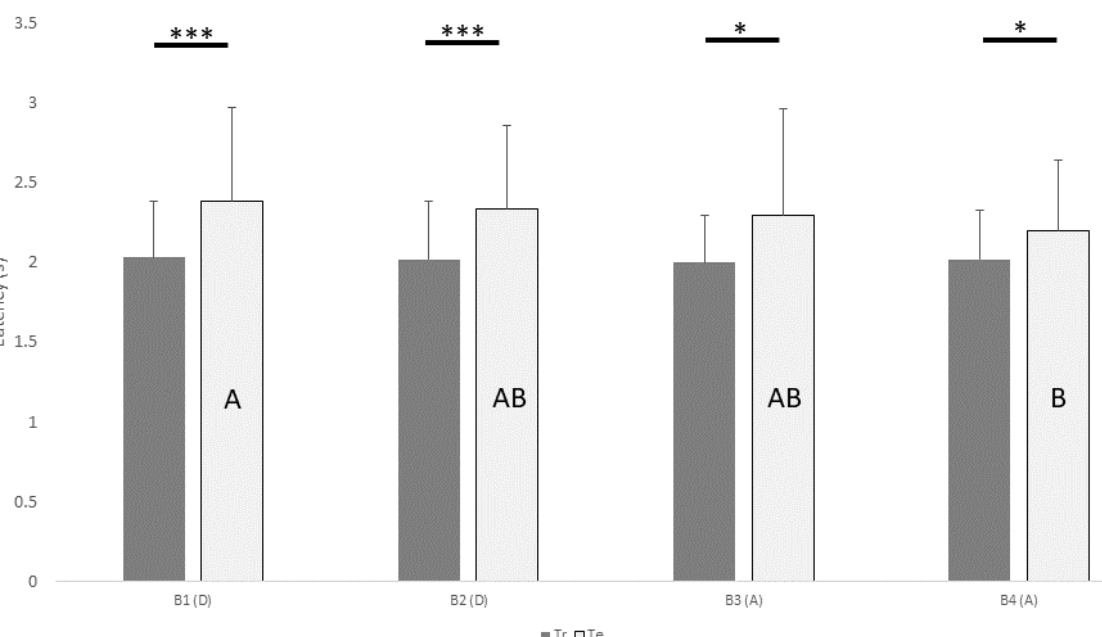
Figure 4. Mean ± SD of the latency from production of sound to the dog’s choice, as function of batch (B1-B4) and type of trial. Significant differences in means between training and test trials within the same batch are flagged by asterisk(s) (* p < 0.05, *** p ≤ 0.001). S ignificant differences in means in test trials between different batches are indicated by different capital letters (e.g. A indicates a signifi- cantly different mean compared to B, but not compared to AB), pairwise comparison after general- ized estimating equations model). Tr, training; Te, testing; D, descending; A, ascending. Post hoc pairwise comparison between latency in training (Tr) and test trials (Te) within each batch showed significant difference in all batches (B1: Tr = 2.0 s, B1: Te = 2.4 s; p = 0.001; B2: Tr = 2.0 s, B2: Te = 2.3 s; p < 0.001; B3: Tr = 2.0 s, B3: Te = 2.3 s; p = 0.040; B4: Tr = 2.0 s, B4: Te = 2.2 s; p = 0.035). Regarding only test trials, the latency time in B1 was higher than in B4 (B1: Te = 2.4 s, B4: Te = 2.2 s; p = 0.002). No difference was found in latency time within the training trials among all batches. No difference was found in latency according of the type of reversal (success/failure). 4. Discussion The MAA of the dogs involved in this experiment ranged from 1.3° to 13.2°, with an average of 7.6°. The dog’s localization ability increased across the experiment, with an average MAA of 11.8° at the beginning of the entire procedure, to 7.4° at the end of it. Dogs’ improvement across the experiment was also evident by a slight decrement in their latency to choose, which went from 2.4 s to 2.2 s. The MAA found in dogs of our experiment had a wider range than that reported for dogs in the scientific literature [15,16], and, in most of our dogs, it fell below the previously reported minimum values (i.e., 7°, in the study by Babushina and Polyakov [15]). One evident element of difference between the present and the previous studies, which could have contributed to the different results, was our larger sample size. This likely allowed